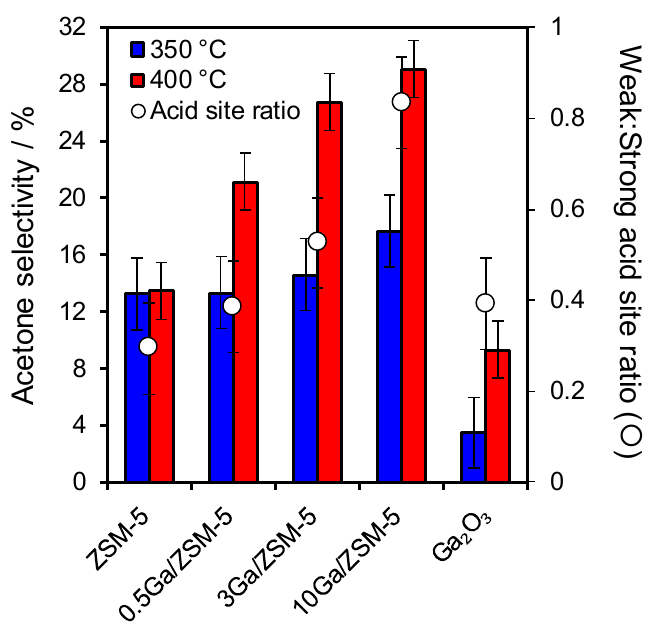
Figure 6. Correlation between acetone selectivity from acetic acid ketonisation at iso-conversion (23% and 29% at 350 °C and 400 °C, respectively) and weak:strong acid site ratio for xGa/HZSM-5. Reaction